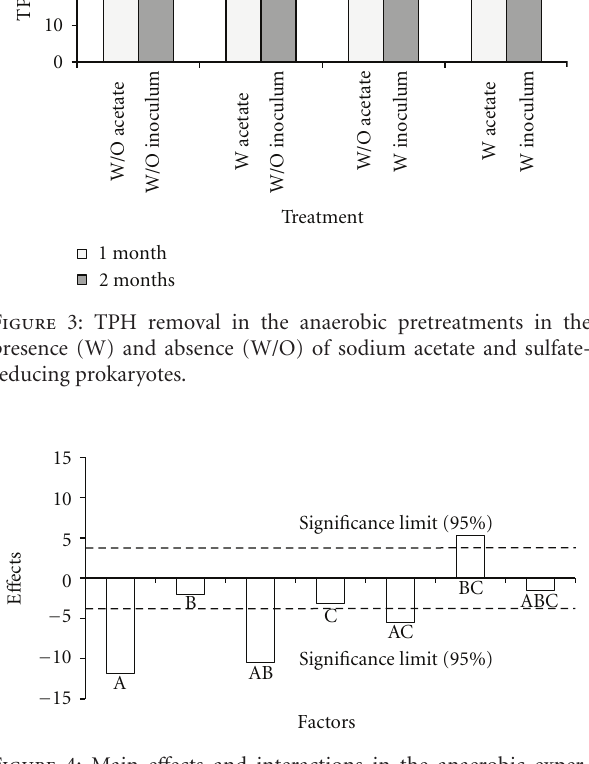
Figure 4: Main e ff ects and interactions in the anaerobic exper- iments (A: sodium acetate; B: treatment time; C: inoculum of sulfate-reducing prokaryotes; operating conditions in Table